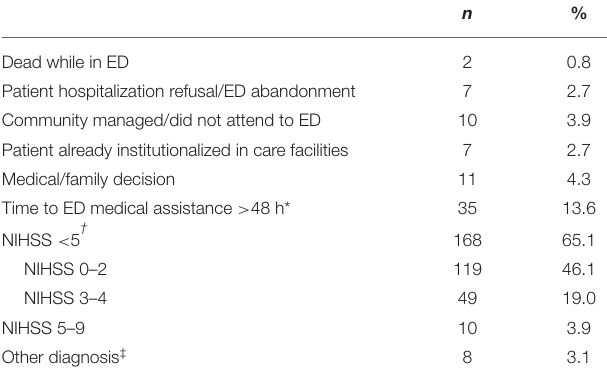
TABLE 1 | Reasons for non-hospitalization of stroke patients ( n =